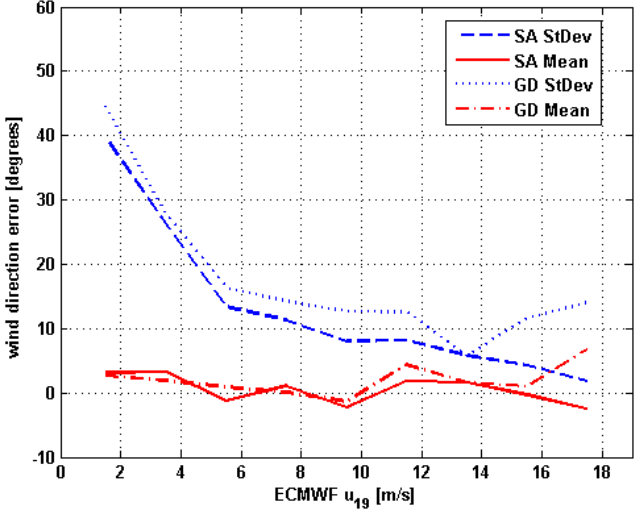
Figure 7 . Binned analysis of mean (red lines) and standard deviation (blue lines) of the difference between the closest ambiguity and the test set φ versus wind